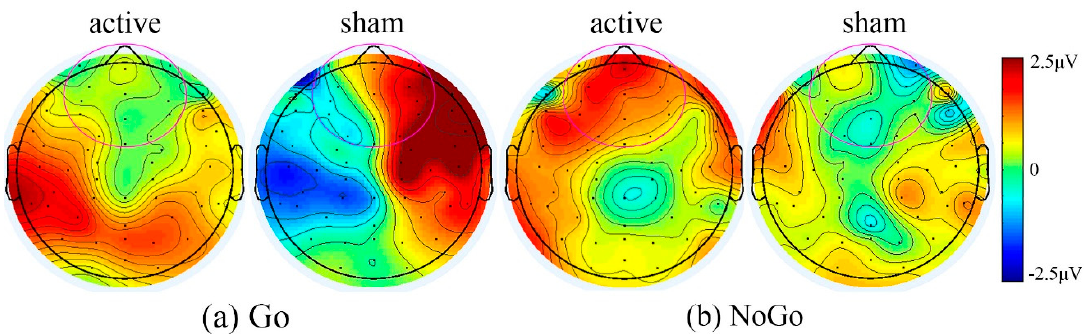
Figure 6. Heat map differences demonstrating decreased N2 activity on NoGo trials across groups following tDCS. Differences are calculated as tDCS treatment minus baseline. Here, a symmetrical color bar is used. The red indicates activity with positive amplitude and the blue indicates negative amplitude and the green indicates activity with zero value. Range = +/ − 2.5 microvolts. The channels used in ERP analysis are highlighted (t = 173ms). ( a ) Go condition. ( b ) NoGo condition.